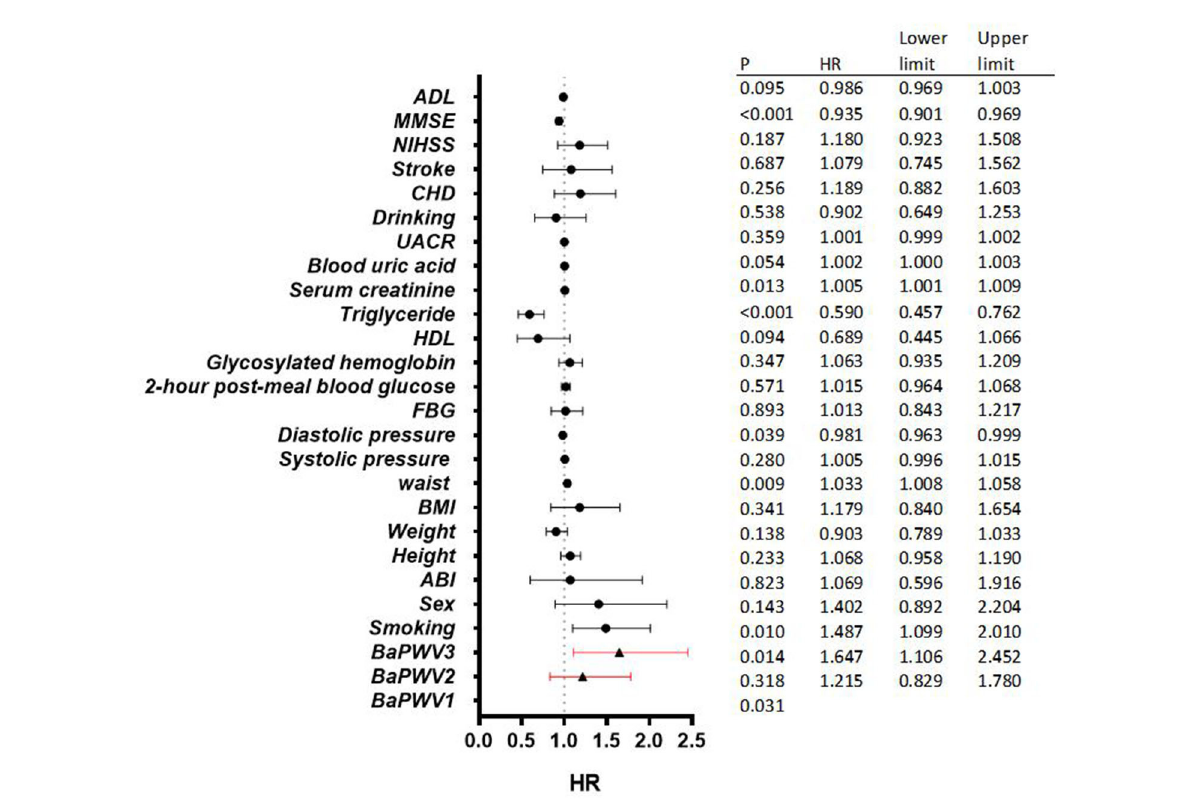
FIGURE6 Forest plot for each covariate in the cox regression